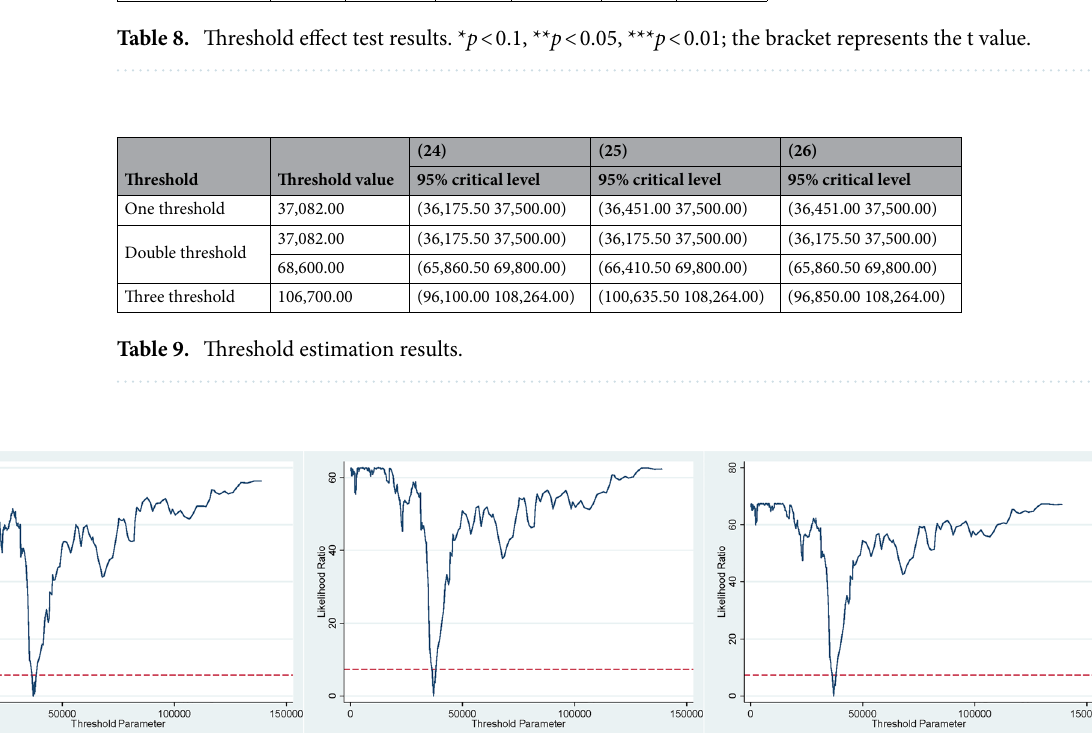
Figure 6. Confidence interval